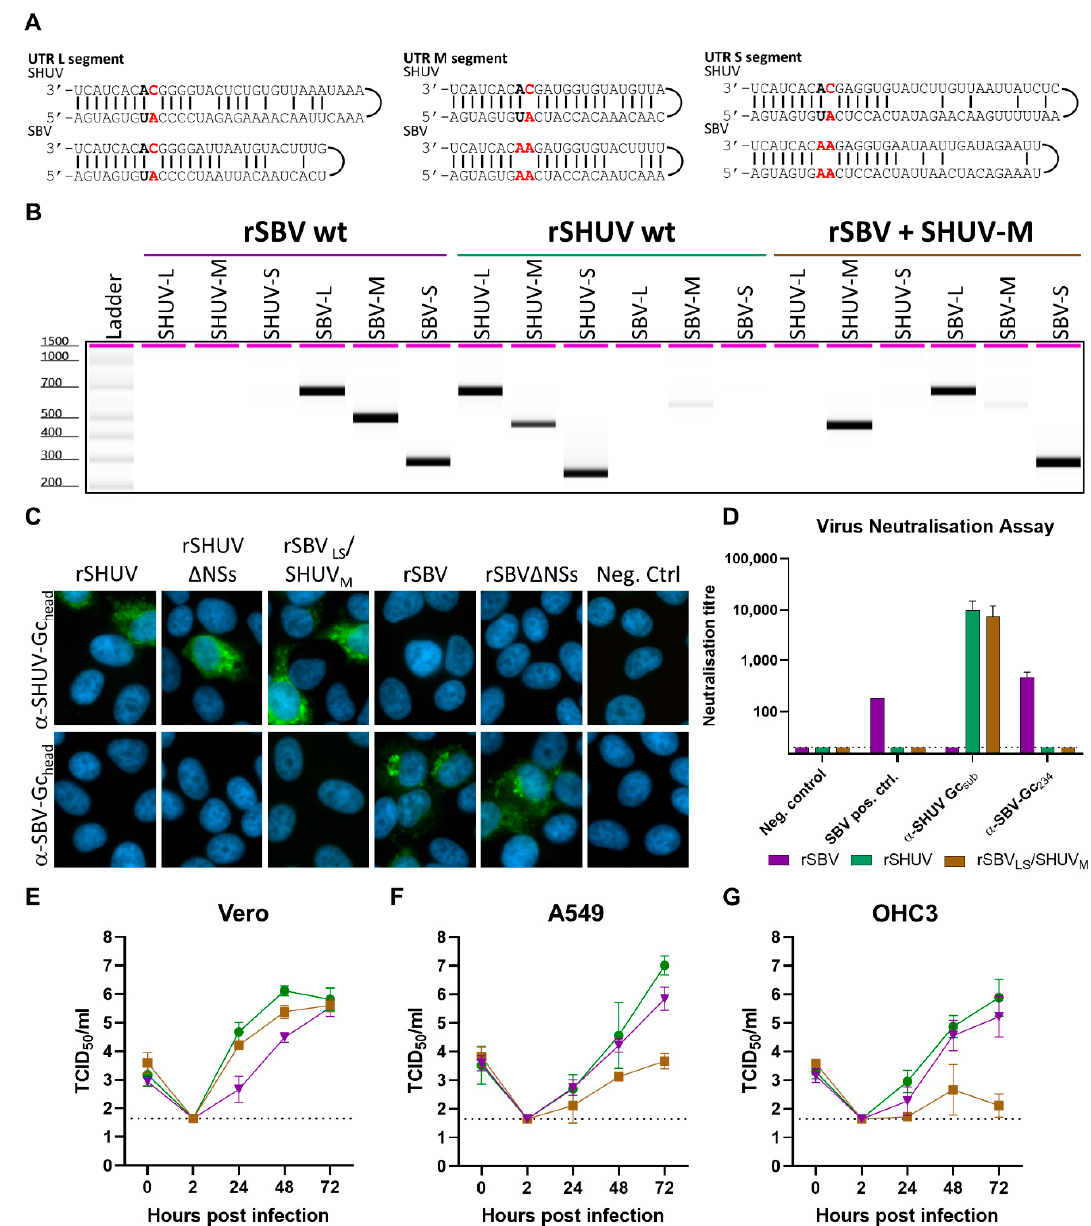
Figure 2. Characterization of a Schmallenberg virus (SBV)-SHUV reassortant. ( A ) The alignment of the UTRs of SBV and SHUV. SHUV contains a single mismatch at position 9, while SBV contains a double mismatch at positions 8 and 9 (indicated in red) in the UTR of the M and S segment. ( B ) The identity of the reassortant was confirmed by PCR using primers specifically recognizing SBV or SHUV L-, M-, or S-segments. PCR products were analyzed with the Tapestation system. ( C ) The immunofluorescence staining of Vero cells infected with rSHUV, rSHUV ∆ NSs, rSBV, or rSBV ∆ NSs at 24 hpi. The cells were infected using an MOI of 0.01. ( D ) Virus neutralization assay with a convalescent sheep serum against SBV, and rabbit antisera raised against the Gc head domains of SBV or SHUV. Replication of rSBV (purple), rSHUV (green) and the reassortant (rSBV LS /SHUV M ), brown) in Vero ( E ), A549 ( F ) and OHC3 cells ( G ). The cells were infected at an MOI of 0.01, and the samples were collected at 0, 2, 24, 48, and 72 hpi. After 2 h, the medium was removed, the cells were washed, and fresh medium was added.